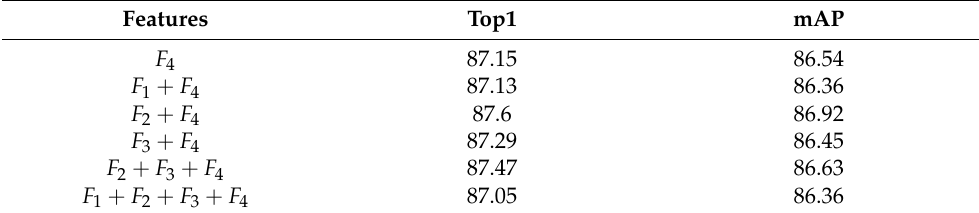
Table 4. Mineral recognition results using different features (%).